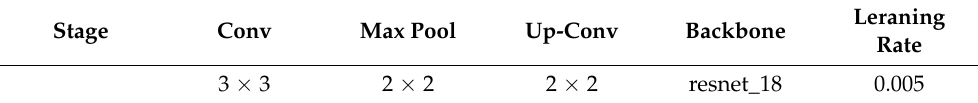
Table 1. The specific parameters of